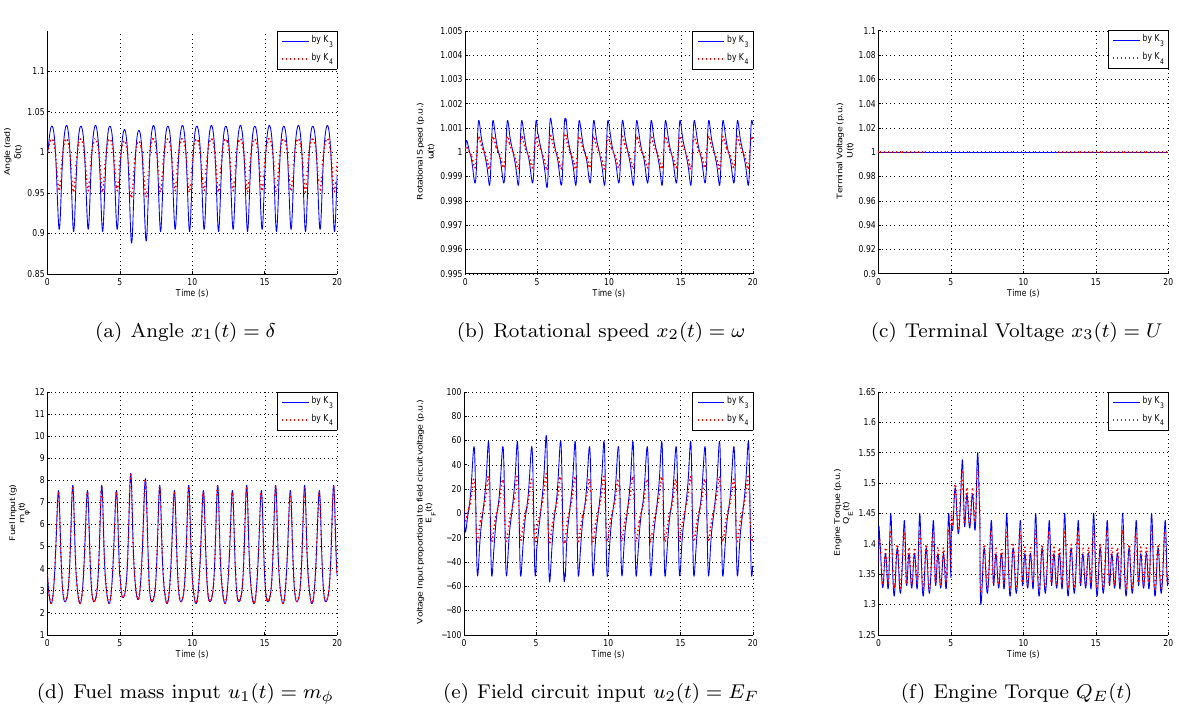
Figure 5: Results of the simulation of the model in eq.(40) with a sudden step in the load torque by the gains: K 3 (solid) and K 4 (dotted) with Θ E modelled as in